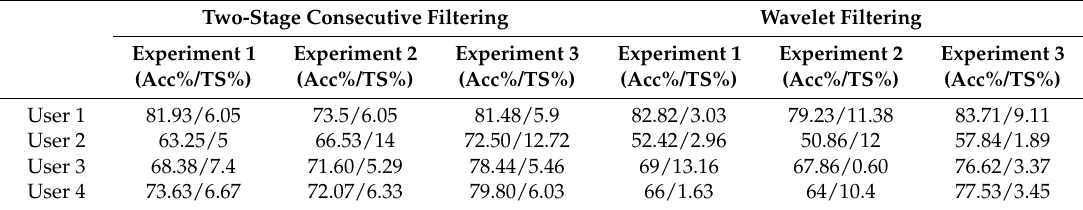
Table 6. Classification performance obtained from obtained from 3-axial acceleration sensors: filtering comparison.